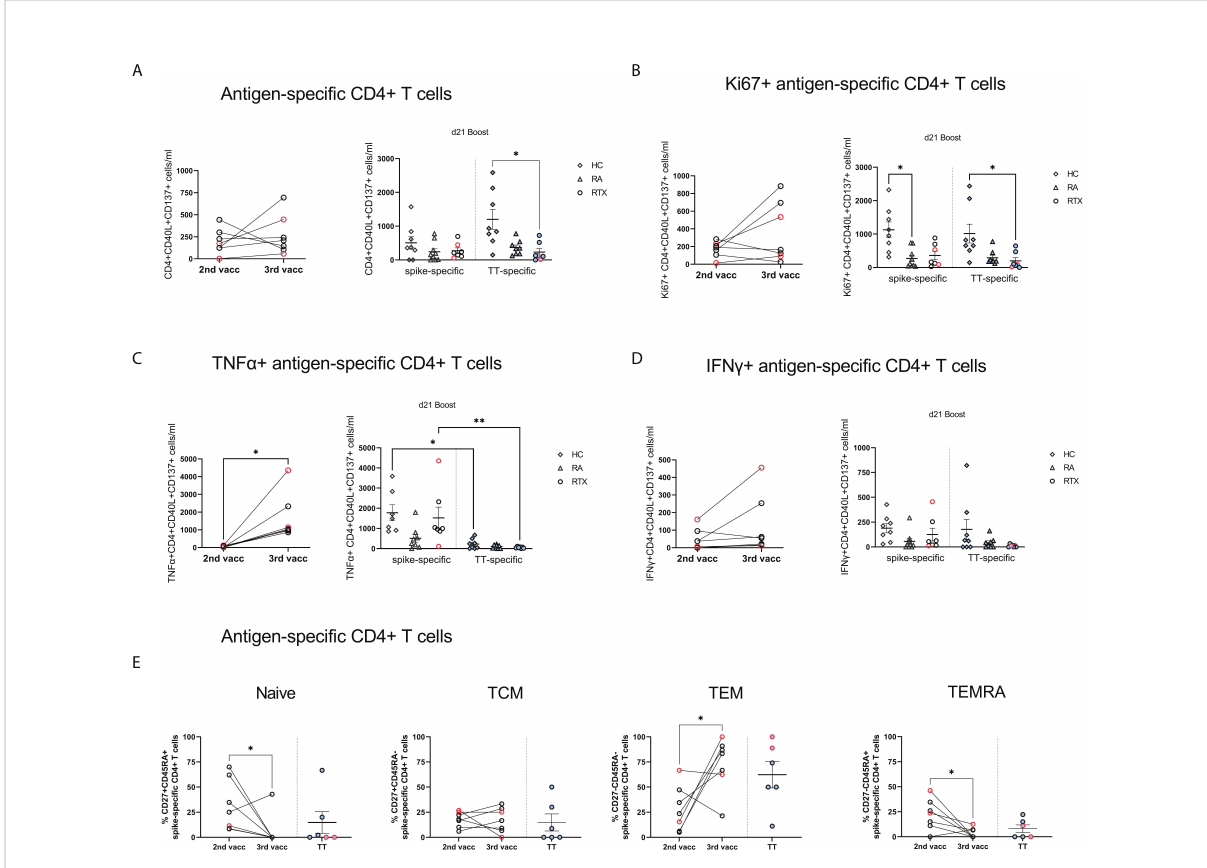
FIGURE 5 Antigen-speci fi c T cells upon 2 nd compared with 3 rd SARS-CoV-2 vaccination in RTX treated patients. (A) Absolute counts (A) , Ki67 expression (B) , TNF a expression (C) , IFN g expression (D) and subset distribution (E) of spike-speci fi c CD4+ T cells after 2 nd compared with 3 rd vaccination in RTX treated patients (n=7). Comparison of spike-speci fi c and TT-speci fi c responses in HC (n=8), RA (n=8) and RTX (n=7) at d21 boost. Mann Whitney test performed for comparisons between 2 nd and 3 rd vaccination data (A-E) . Kruskal-Wallis with Dunn´s post-test for comparisons between the groups (A-D) . *p < 0.05, **p < 0.01. Color code: previously infected individuals are indicated in red; control TT results are indicated by blue fi lled circles. TCM, central memory T cells; TEM, effector memory T cells; TEMRA, terminally differentiated memory T